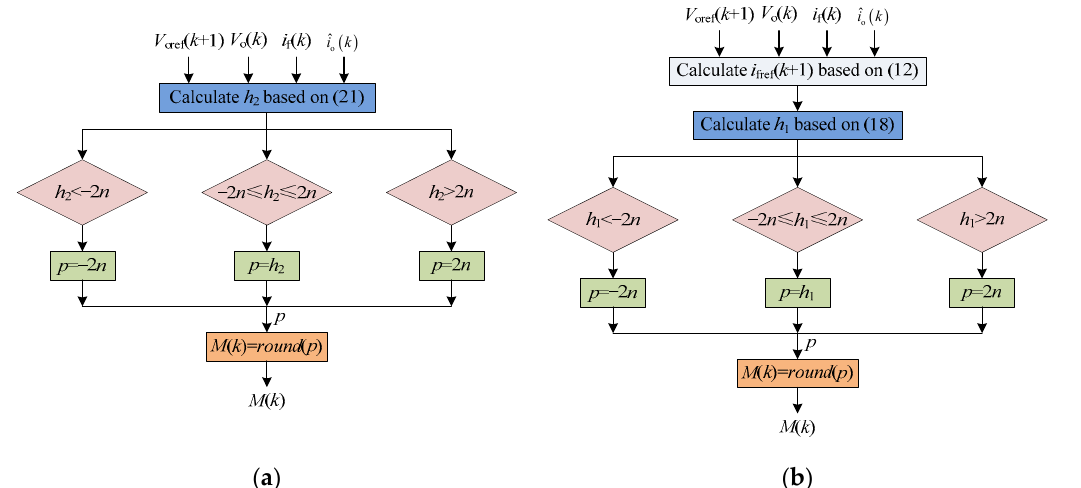
Figure 4. Flow chart of the upper control algorithm: ( a ) a 2 ≥ a 1 . ( b ) a 2 < a 1 .